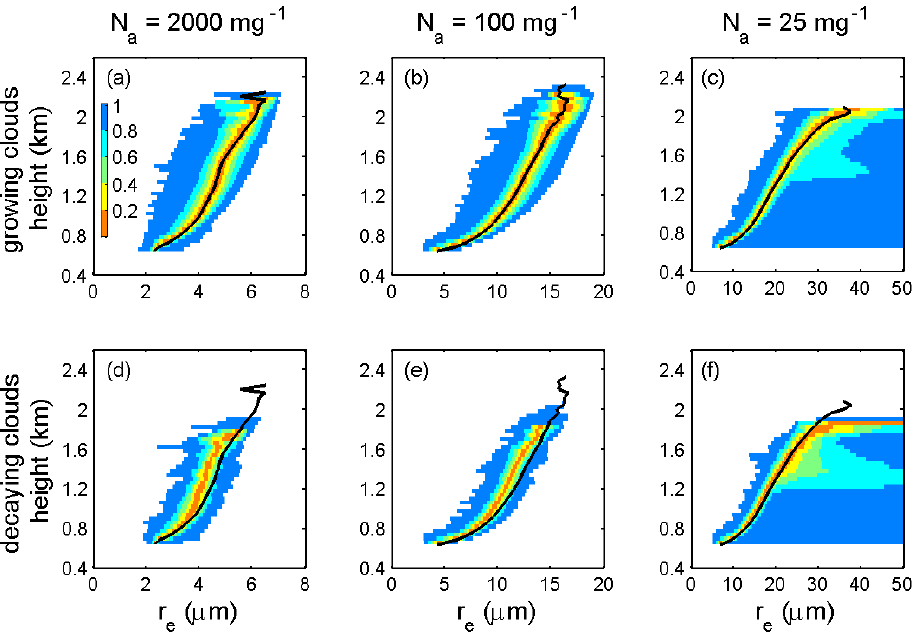
Fig. 4. r e profiles from different cloud samples in the last 4h of simulation for the three cases. (a, b, c) Growing clouds, maximum w > 2 . 0ms − 1 ; (d, e, f) decaying clouds, maximum w < 2 . 0ms − 1 . Black lines are the 50th percentiles of the r e from all cloud samples for reference (same as in Fig. 1). Color scale is the same as Fig.